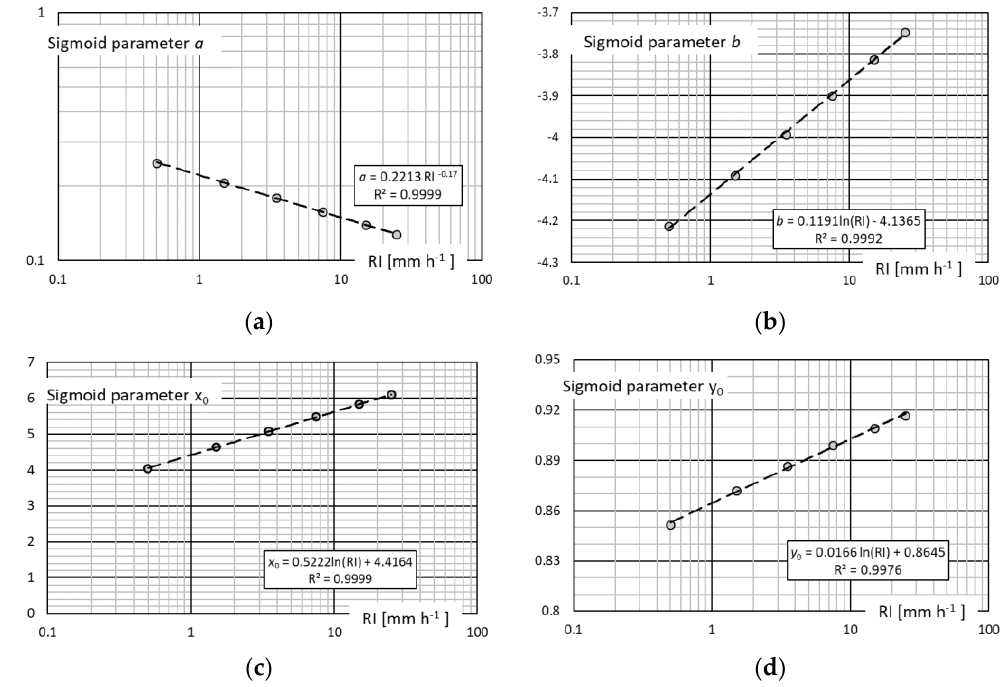
Figure 8. Sigmoidal parameters associated with the mean value of each RI class (circles) and fitted by either power law or logarithmic curves (dashed lines) ( a ) parameter a ; ( b ) parameter b , ( c ) parameter x 0 ; ( d ) parameter y 0 .